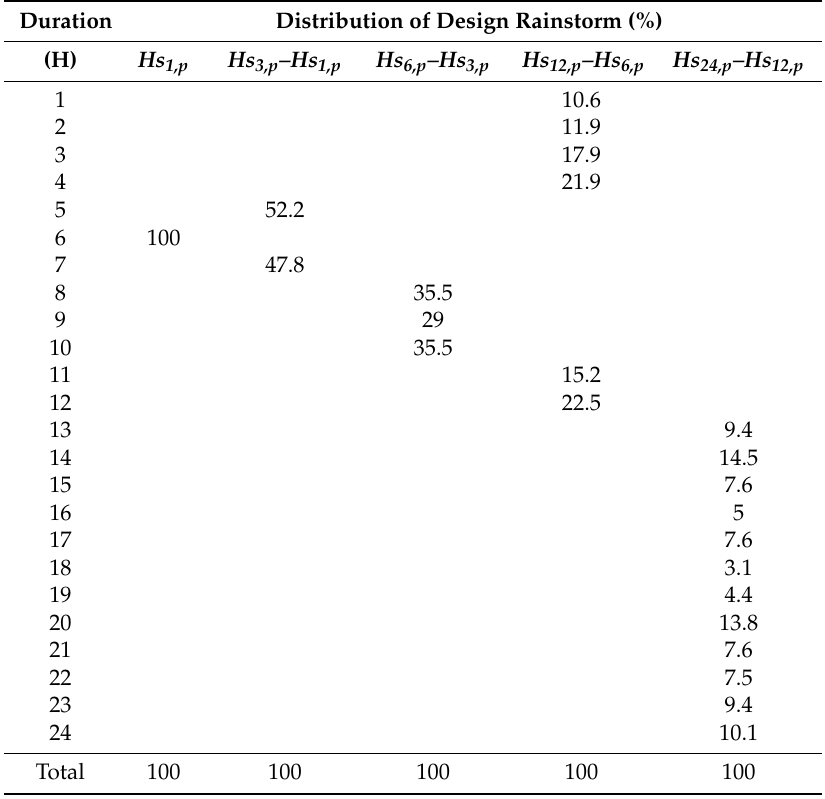
Figure 3. Calculation diagram of the design rainstorm, where a d and b d are linear fitting parameters; Hmax represents the max point rainfall with different durations d ; the coefficient of modulus Kp value, the maximum point isohyetal rainfall maps, and the linear fitting parameters in empirical formulas can be known from the regional practical hydrological handbook which provides many empirical formulas and parameter values for the hydrological design in the region. Table 1. Design rainstorm pattern with 24 h duration in Zichang